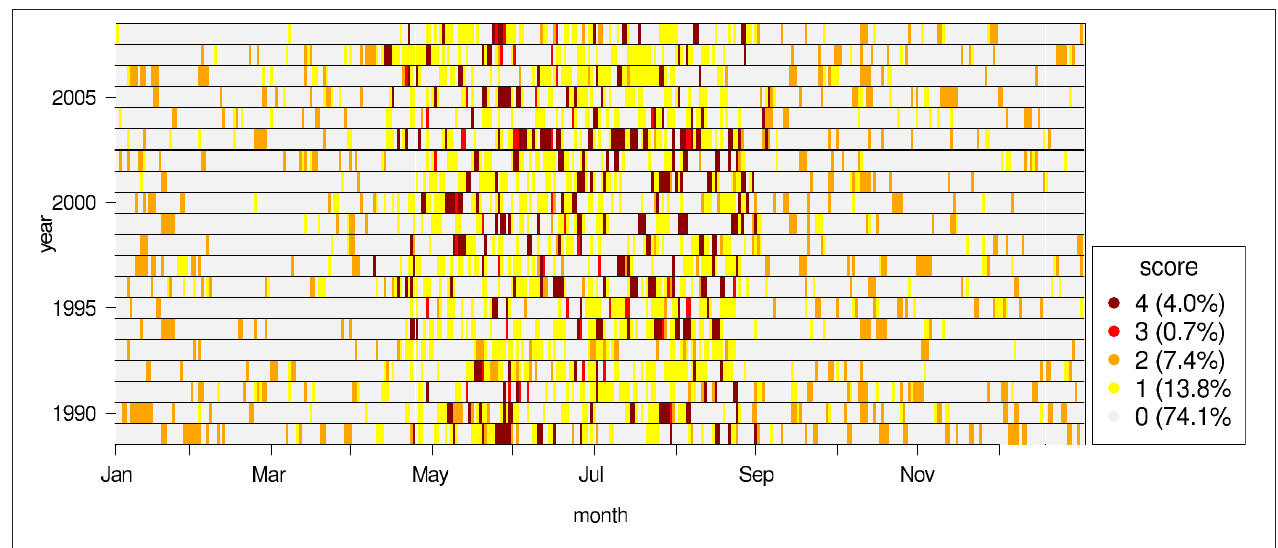
FIGURE 4 | Daily score of the four criteria combinations defined in Table